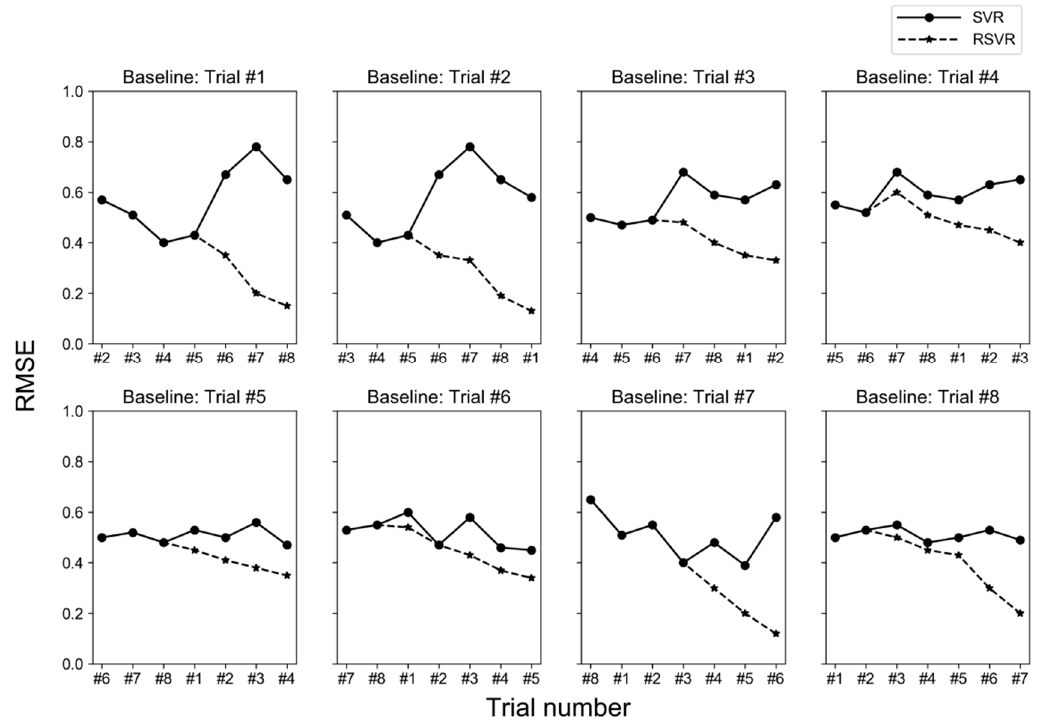
Figure 3. Comparison of the RMSE of subject #16’s SVR and RSVR estimates with di ff erent driving trials used as baselines.